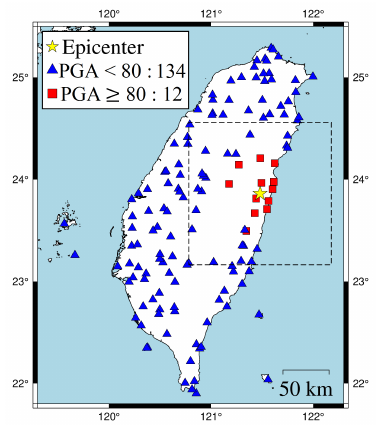
Figure 7. 18 April 2021 Hualien earthquake ( M L = 6.2, depth = 14.4 km). The dotted box is the area close to the hypocenter and chosen to be investigated in Figure